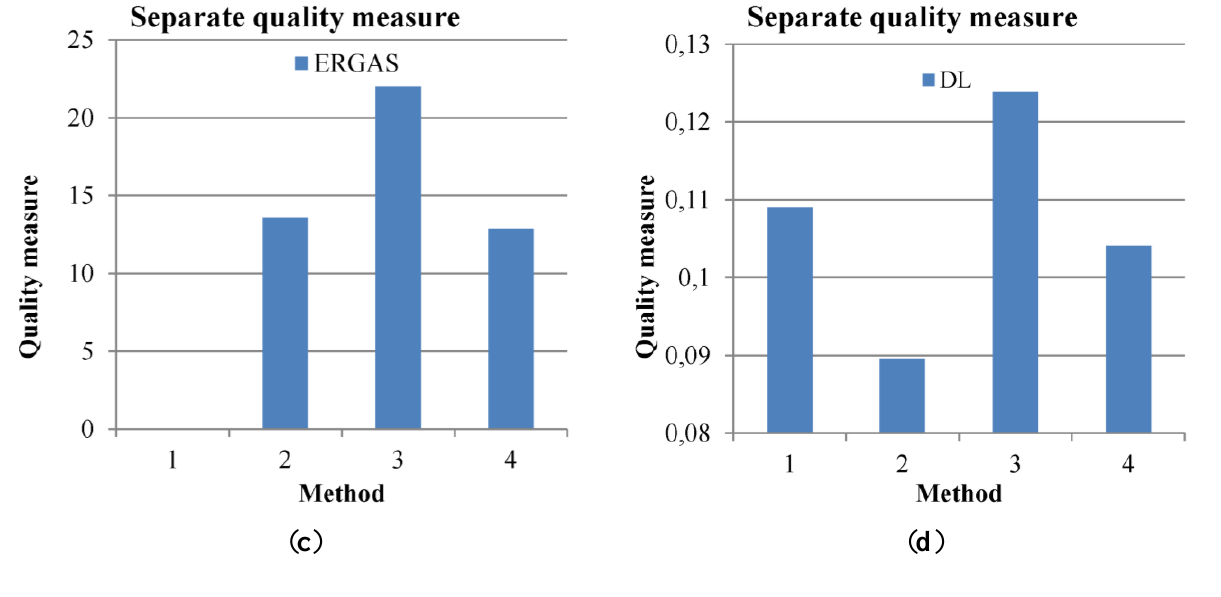
Figure 6. Quality assessment of interpolation methods: 1—NN, 2—ZP, 3—BIL, and 4—CUB for IKONOS data using different separate quality measures. ( a ) 1−QLR, ( b ) SAM, ( c ) ERGAS, ( d ) DL .